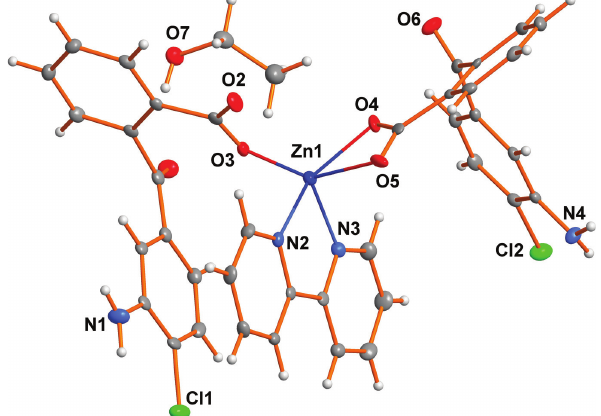
Table 2: Fractional atomic coordinates and isotropic or